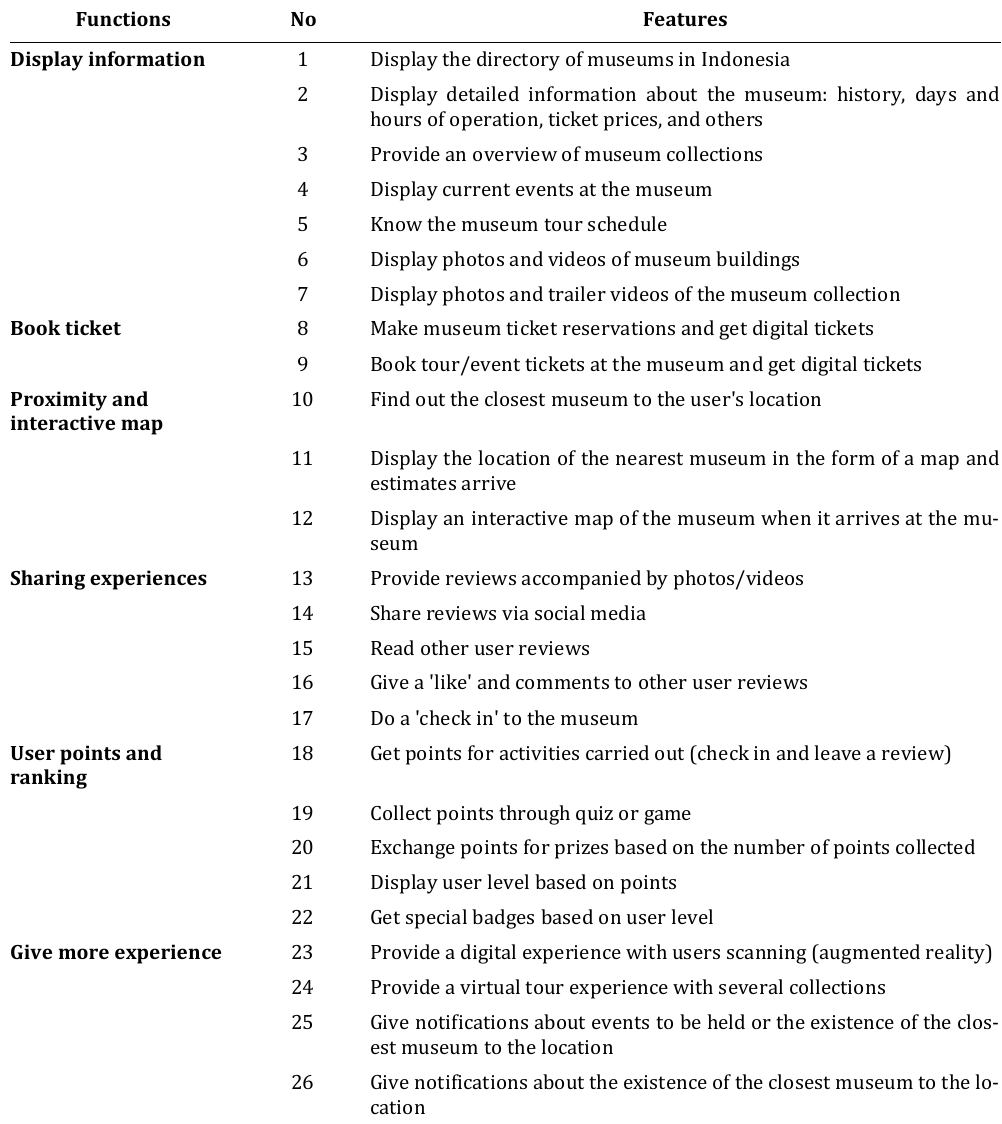
Table 4 Features of Museum Mobile